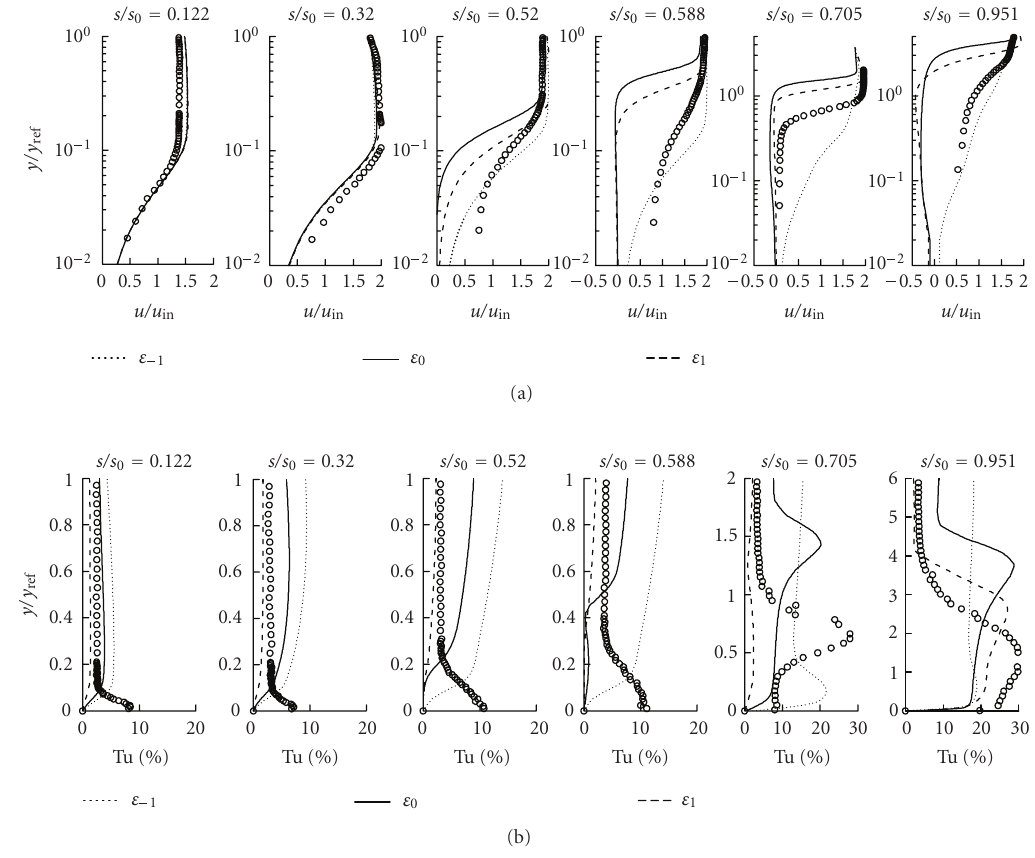
Figure 6: Velocity and turbulence profiles on the suction side for di ff erent inlet values of ε for the undisturbed case with the LCL model.